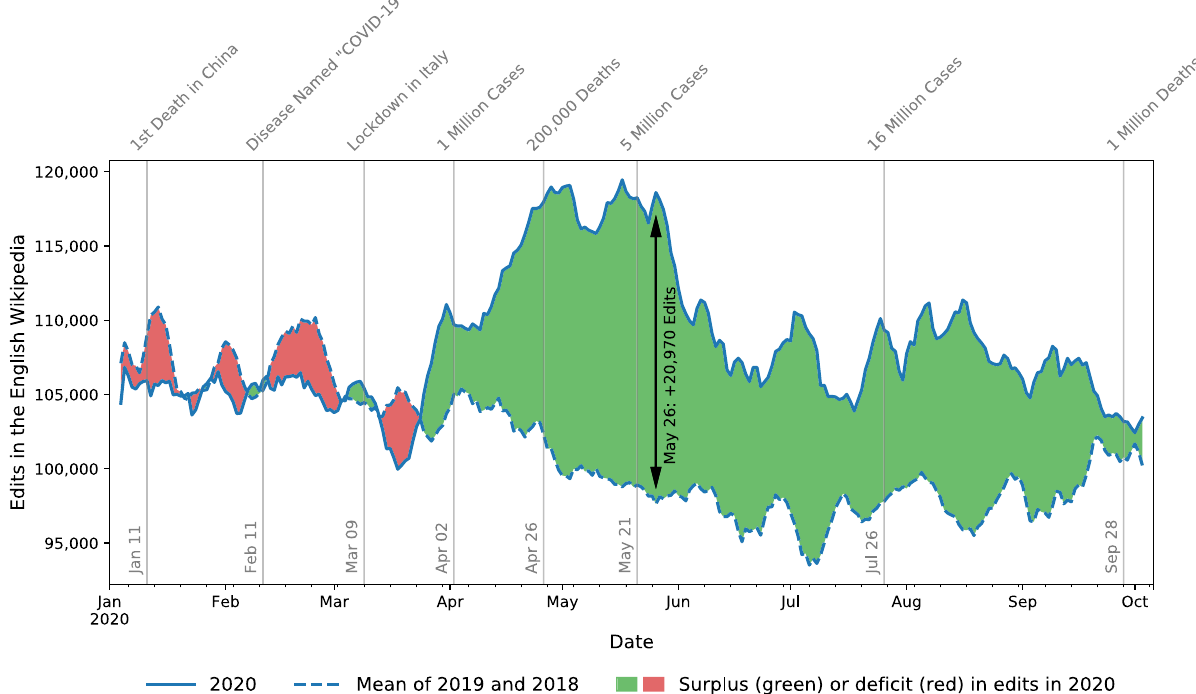
Figure 1. Edit volume in the English Wikipedia increased during COVID-19 mobility restrictions. We visualize the rolling 7-day average edit volume in the English Wikipedia from January to October 2020 alongside the daily mean of 2019 and 2018, only considering non-bot edits to Wikipedia articles. Vertical lines mark major developments during the COVID-19 pandemic in 2020 (Via https:// wikim ediaf ounda tion. org/ covid 19/ data). After the first Western countries (e.g., Italy) enforced mobility restrictions in early March, edit volume stagnated briefly before rising sharply—a trend that prevailed until late May, where the maximum difference in rolling 7-day average edit volume reached 20,970. Although this initial sharp increase in edits later declined, a surplus persisted until October. Until September 31st, editors produced 8.4% ( 7.3% ) more edits in 2020 than in 2019 (2018), an increase of 2.2 million (2 million) edits (Supplementary Table 2). Much of this edit surplus appears to stem from periods of mobility restrictions in the spring of